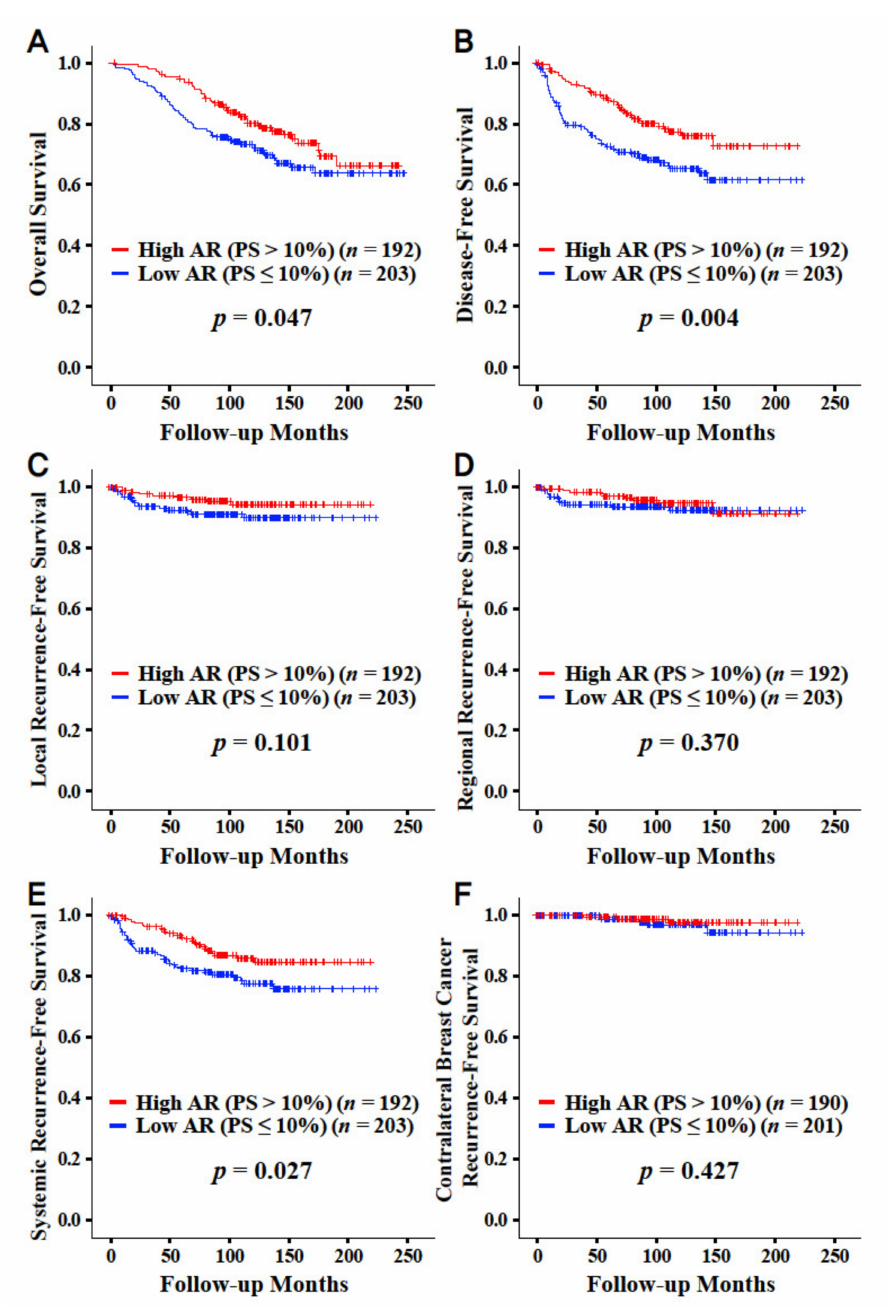
Figure 1. Overall survival and disease-free survival curves according to the proportion score with the cut-o ff value of 10% by immunohistochemistry regarding AR. Overall survival ( A ), disease-free survival ( B ), local recurrence-free survival ( C ), regional recurrence-free survival ( D ), systemic recurrence-free survival ( E ), and contralateral breast cancer recurrence-free survival ( F ). Abbreviation: AR, androgen receptor; PS, proportion